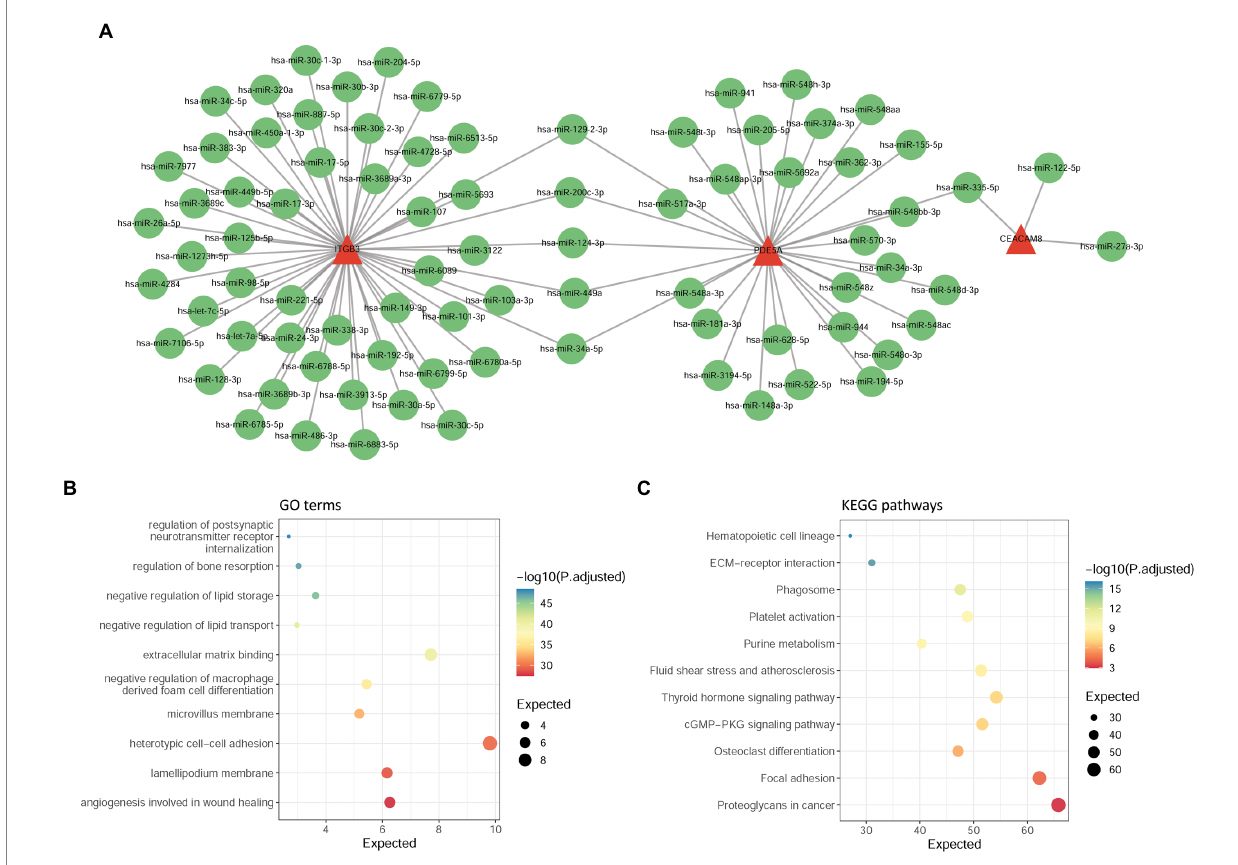
FIGURE 6 Analysis of upstream miRNAs of hub-shared genes. (A) The miRNA-target network constructed by four hub-shared genes and their predicted miRNAs. (B) GO enrichment results for upstream miRNAs of hub shared genes. (C) KEGG pathway enrichment results for upstream miRNAs of hub-shared genes. GO, Gene Ontology; KEGG, Kyoto Encyclopedia of Genes and Genomes.